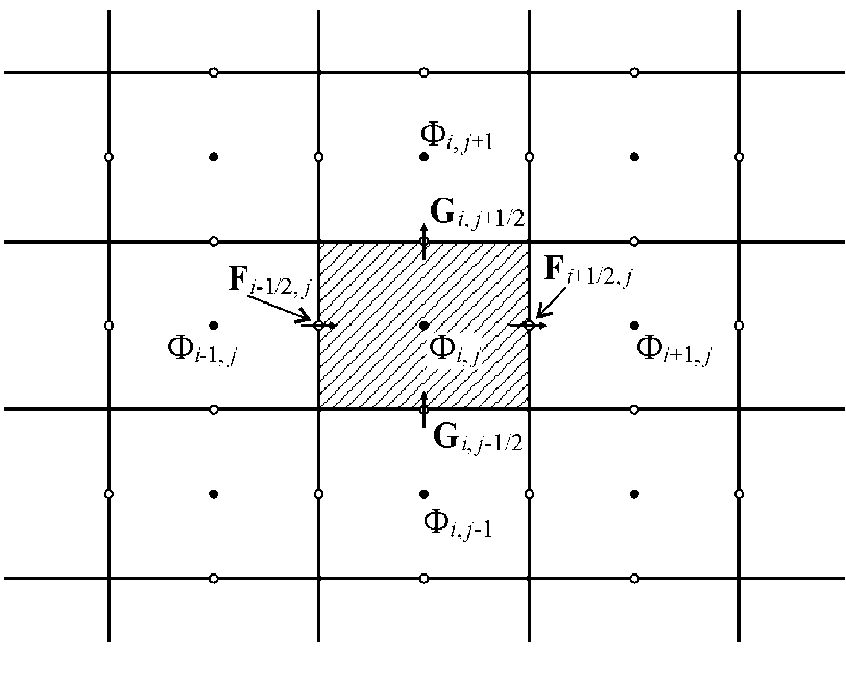
Figure 1. 2D finite-volume